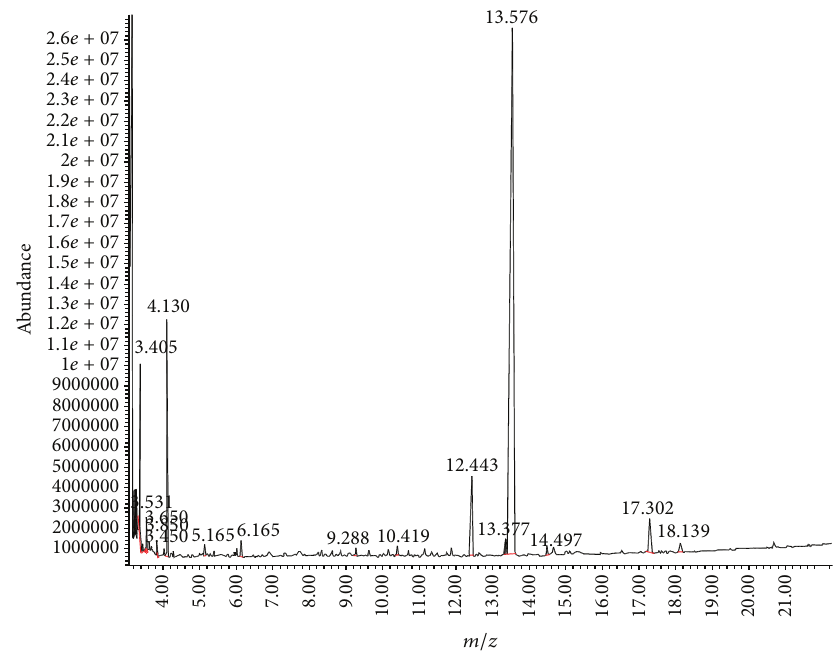
Figure 5: The GC map of phenanthrene conversion and removal by potassium ferrate system.